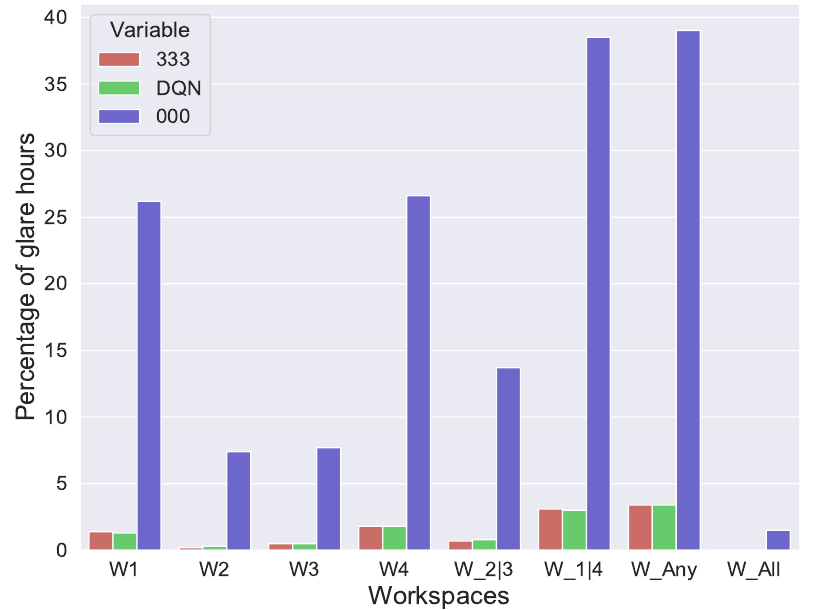
Figure 14. Comparison of glare hours with extreme cases of EC glass with the approach of the DQN